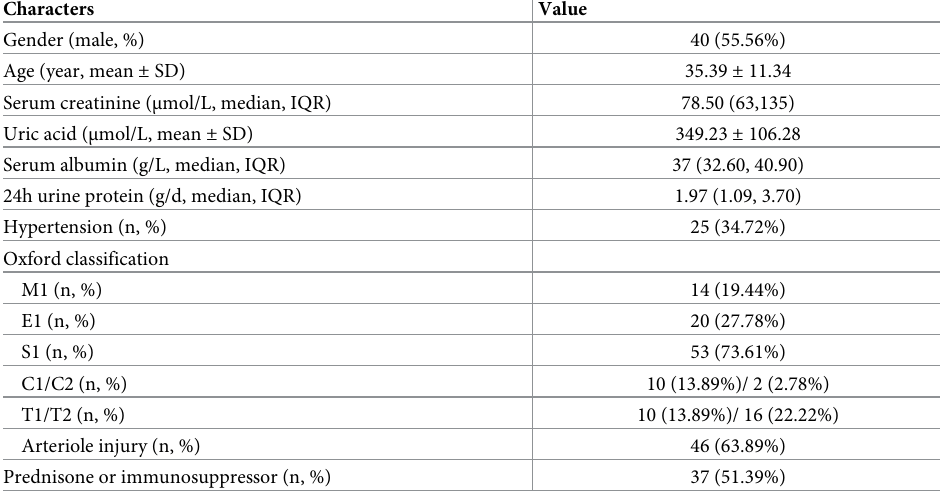
Table 2. The baseline data for patients with